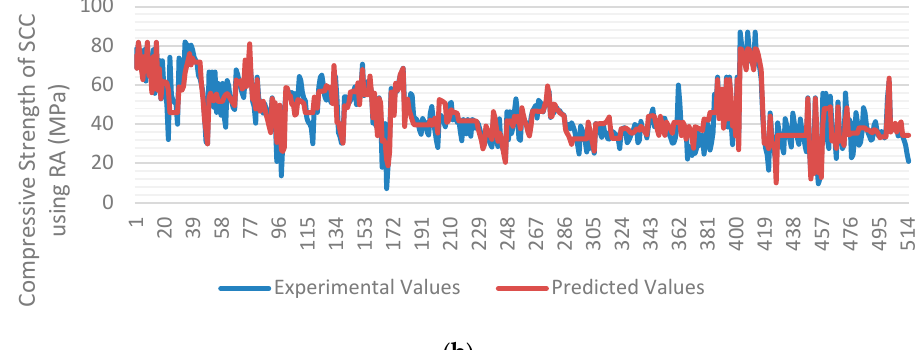
jected values, whereas the blue line represents experimental values of SCC compressive